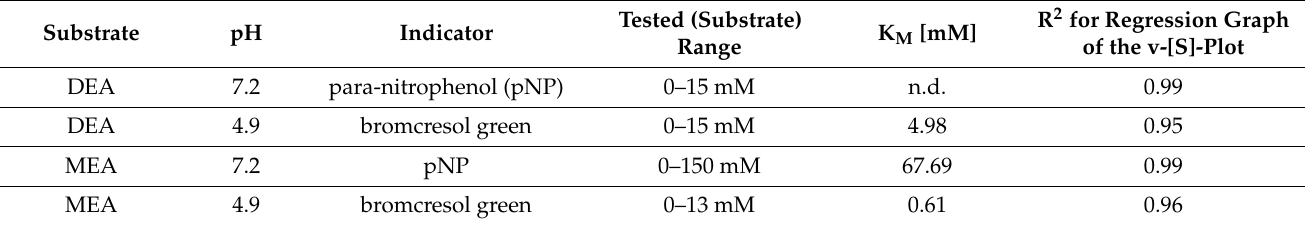
Table 2. Michelis–Menten constants of ACut2-6hp to DEA and MEA at pH 4.9 and 7.2.